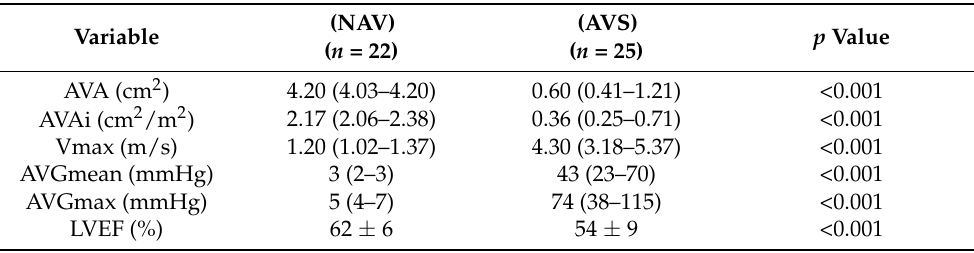
Table 2. Parameters evaluated from the echocardiogram. Data are shown as median (percentile 25–percentile